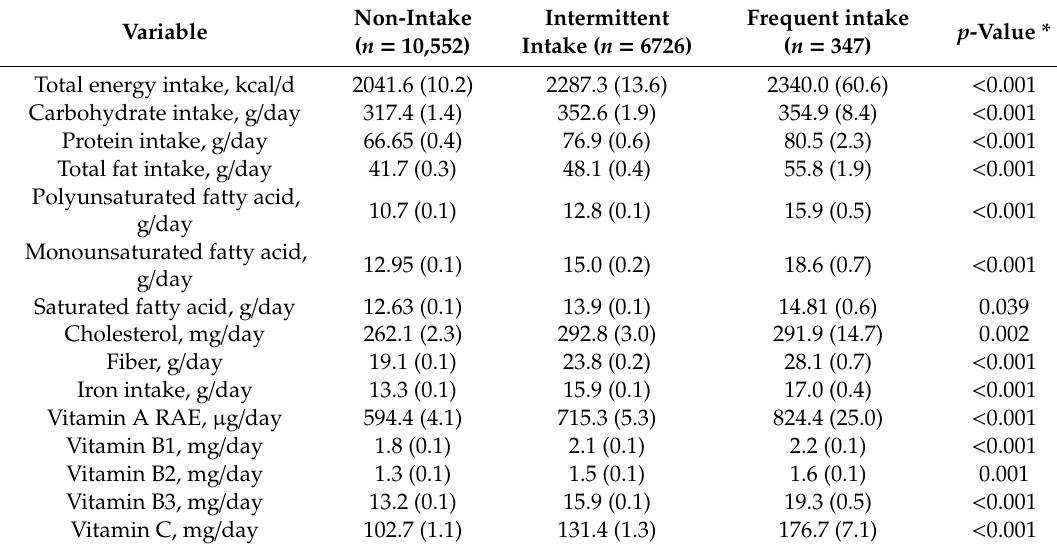
Table 3. Dietary characteristics of the study population according to the frequency of peanut